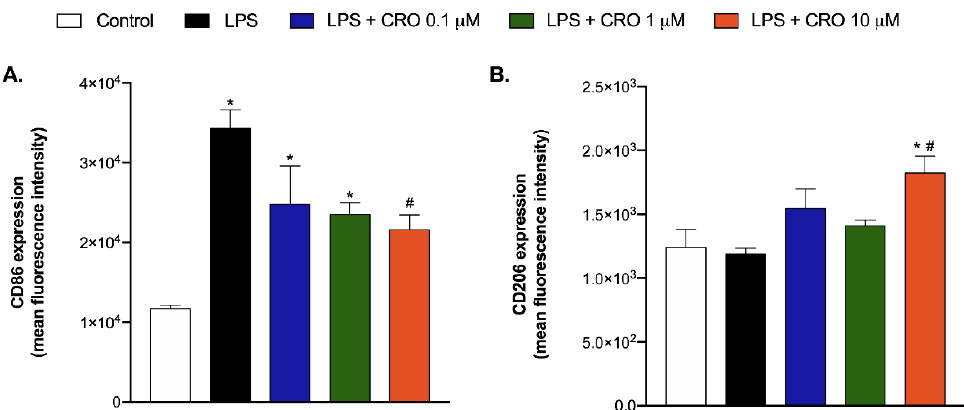
Figure 6. CD86 and CD206 expression in BV-2 mouse microglial cells line. BV-2 cells were treated according to the following groups: control (medium), LPS (100 ng/mg), LPS + 0.1 µM crotalphine, LPS + 1 µM crotalphine, and LPS + 10 µM crotalphine. For the LPS + crotalphine (CRO) group, the cells were pretreated with LPS for 24 h, the medium was removed, and then the cells were treated with different concentrations of crotalphine (0.1 µM, 1 µM, and 10 µM) for 24 h. The mean fluorescence intensity of CD86 ( A ) and CD206 ( B ), markers of M1 and M2 cell phenotypes, respectively, was determined via the flow cytometry assay. Results represent the group mean (±SEM). n = 3 assays, each one in duplicate. * p < 0.05 indicates a statistically significant difference in relation to the control group. # p < 0.05 indicates a statistically significant difference in relation to the group LPS. The one-way ANOVA test was used followed by Tukey ’s test.